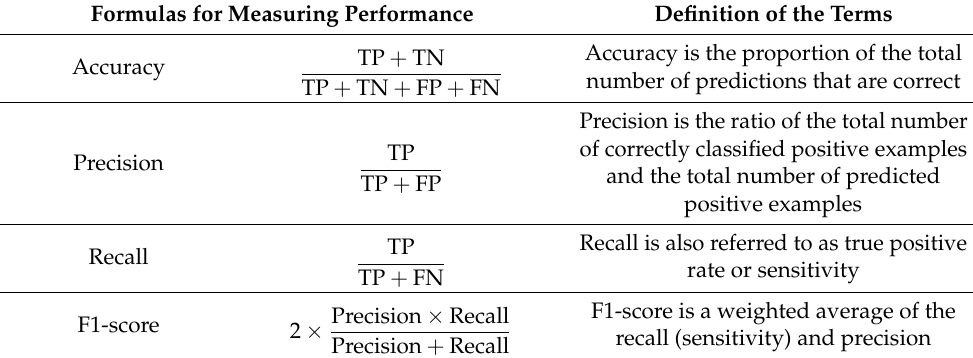
Table 6. Classification performance measures.